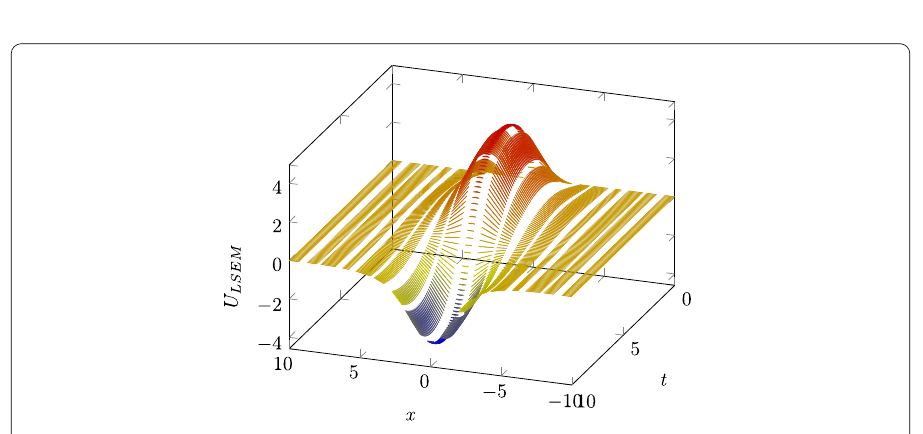
Figure 9 Comparison between the LSEM and exact solutions for Example 5.3 at t = 1 with N = 3, N e = 30 and k = 0.01